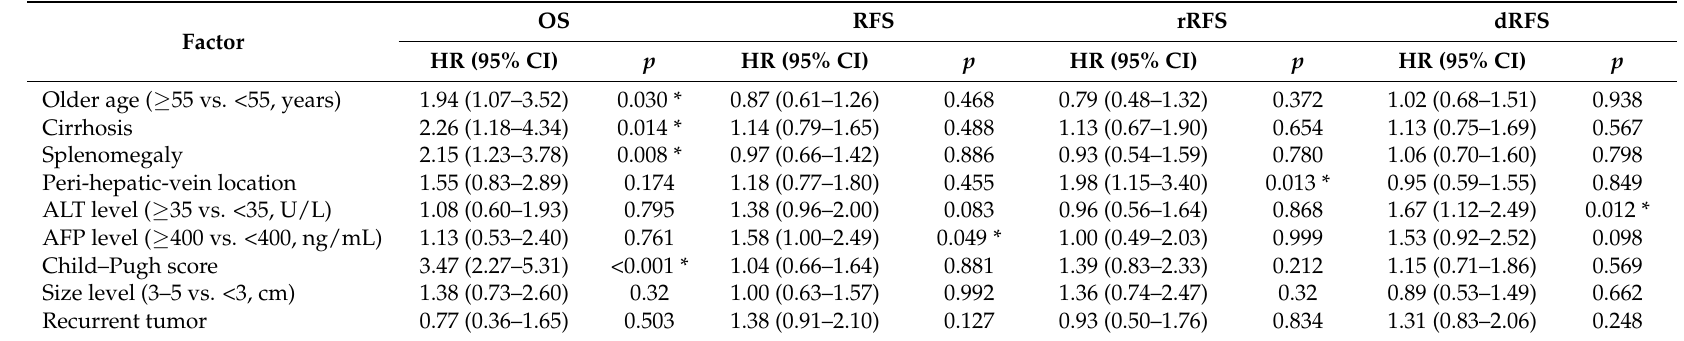
Table 2. Univariate analysis for prognostic factors.